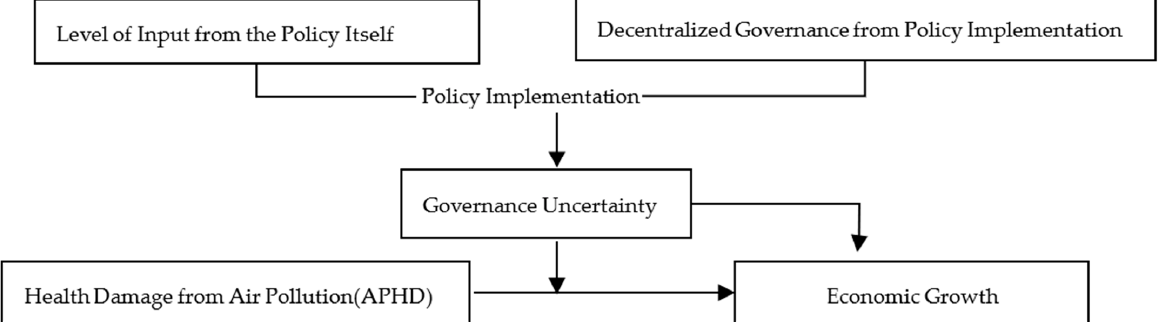
Figure 1. The theoretical framework.